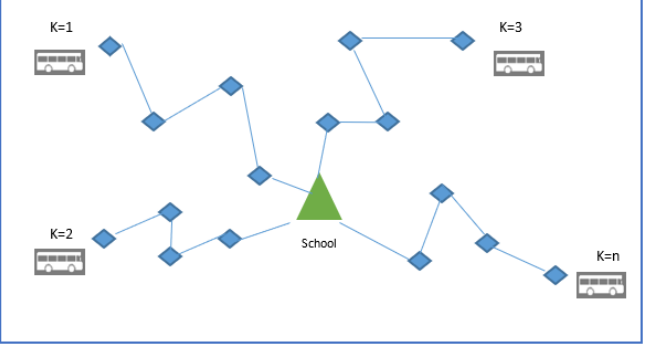
Fig. 1. General representation of the school bus routing problem